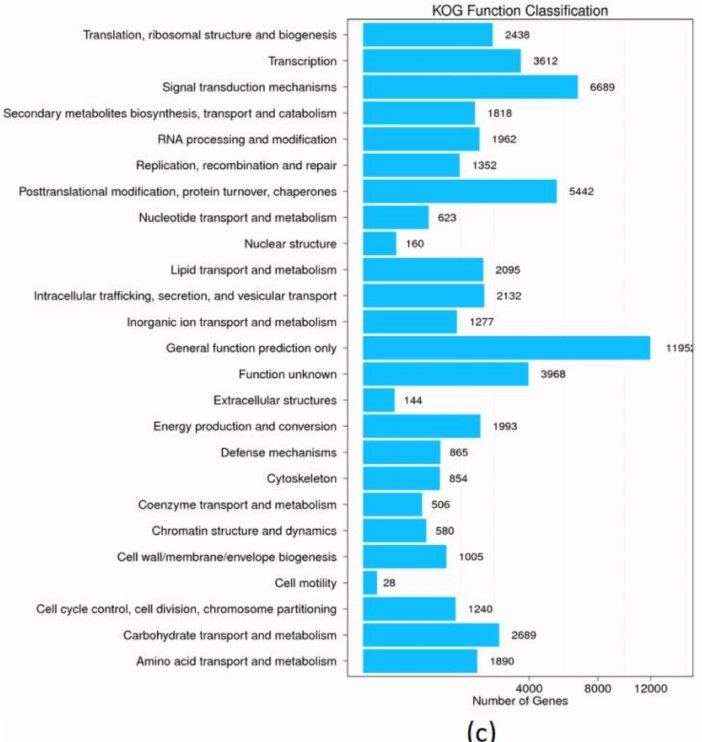
Figure 2. Graphical representation of unigene distribution based on ( a ) Gene Ontology (GO) classification and ( b ) Kyoto Encyclopedia of Genes and Genomes (KEGG). Genes are divided into six branches according to the participating KEGG metabolic pathways: cellular processes, environmental information processing, genetic information processing, human diseases, metabolism, organisms, medicines drug development. ( c ) Eukaryotic Ortholog Groups (KOG) annotation of putative proteins. All 47,776 putative proteins showing significant homology to those in the KOG database were functionally classified into 25 groups. The X -axis represents the corresponding unigene number, and the Y -axis represents the functional